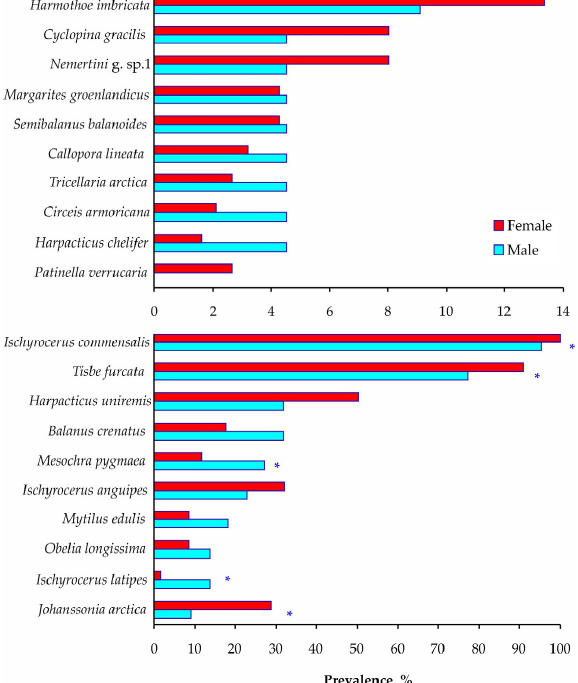
Figure 4. Total infestation prevalence on Paralithodes camtschaticus adult males and females with new shells in Dalnezelenetskaya Bay in summers during the period 2009–2013. Asterisks indicate significant differences (Chi ‐ squared test, p < 0.05).